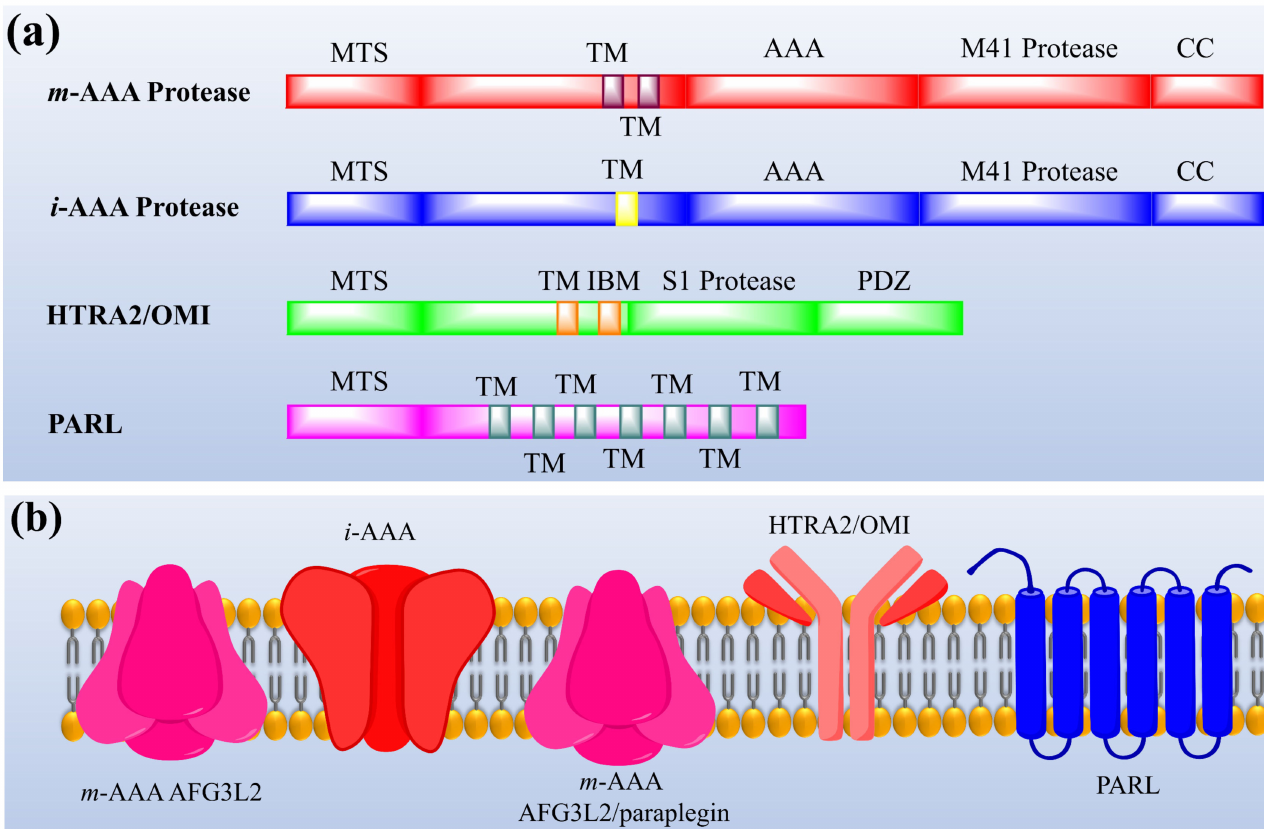
Figure 1. The representation of ( a ) structure and ( b ) topology of proteases. TM: